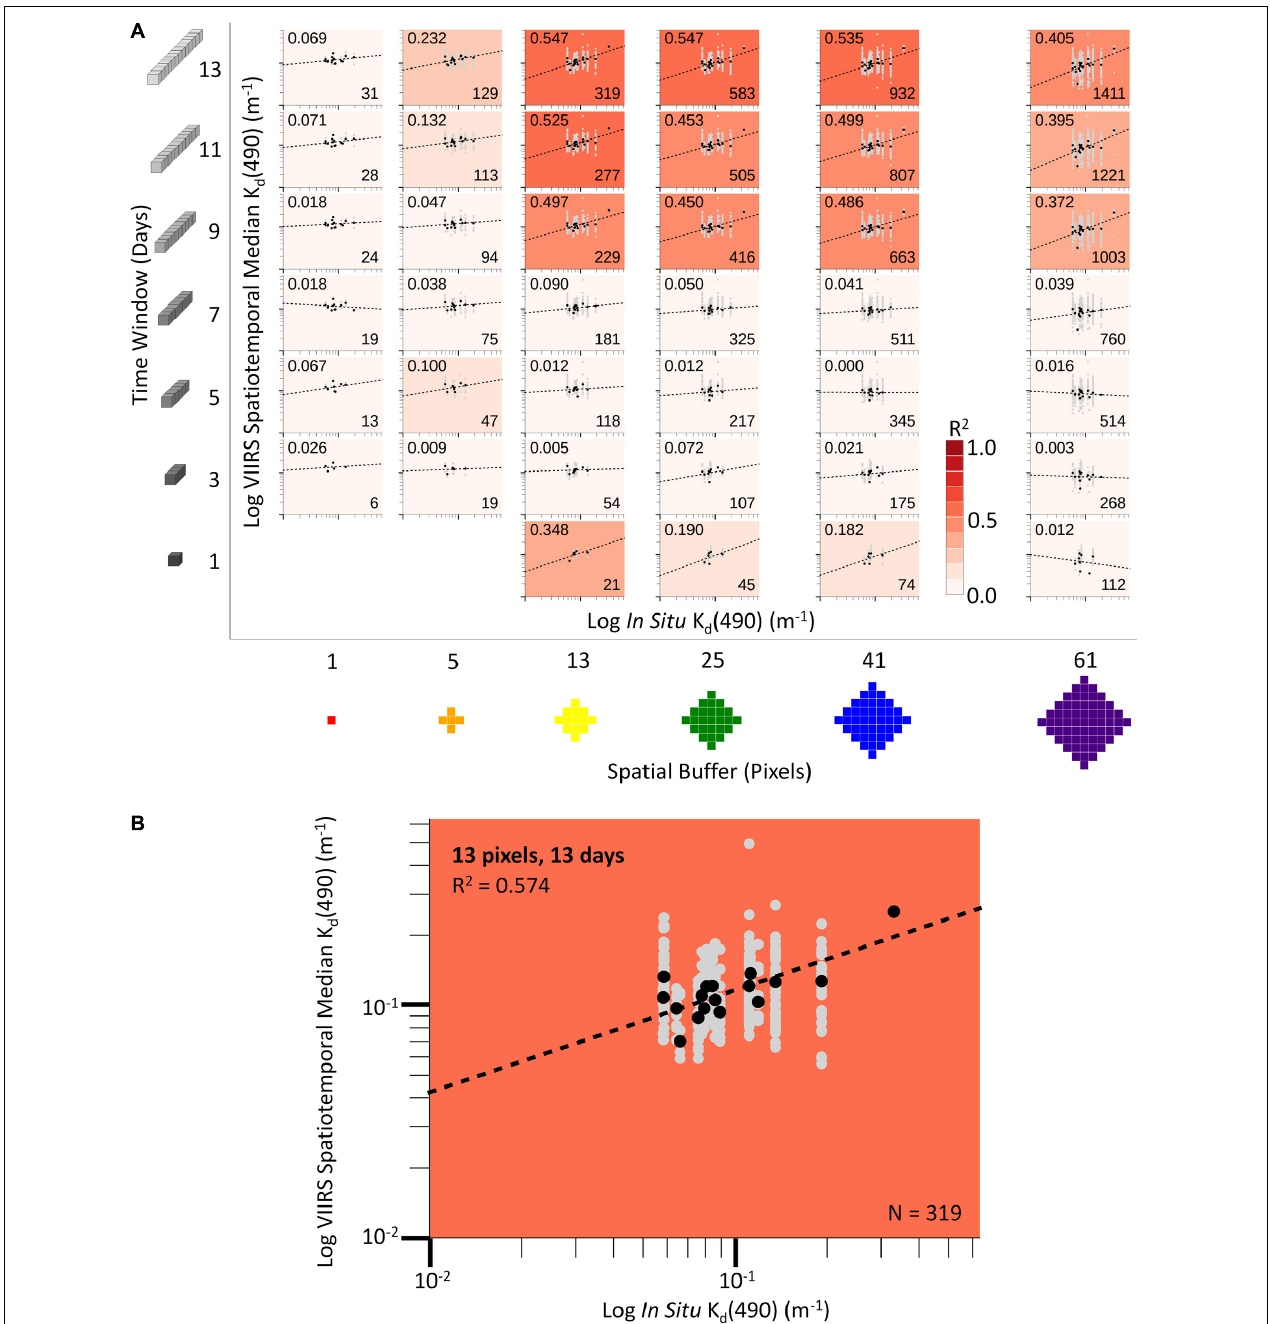
FIGURE 7 | (A) Correlation matrix of in situ and VIIRS measures of log-transformed K d (490) over a 4-years in situ measurement period at one southwest Puerto Rico location ( Figure 5 ) for a range of spatial buffers and time windows applied to the satellite data. The outer horizontal axis indicates the spatial buffer and the outer vertical axis represents the time window, with icons on each representing the space (or time) domain. Together, the time window and spatial buffer make the spatiotemporal cube of satellite data from which satellite values are compiled (gray circles) and the median of those is calculated. Shading of each plot represents the R 2 value of individual regression lines between the median satellite observation and the in situ observations. Scatterplots with two or fewer matchups are excluded. For each scatterplot, the horizontal axis values are the in situ observations from the site in Figure 3 , which were taken between 2016 and 2019, and the vertical axis values are all satellite observations associated with that in situ measurement within the time window and space buffer indicated. The number in the upper left corner is the R 2 value for that plot; the number in the bottom right corner is the total number of satellite observations (gray circles) displayed in the plot. (B) Enlarged scatterplot for recommended spatiotemporal aggregation (13-pixels, 13-days). Axis tick values in (B) are the same as all scatterplots in (A) and major tick marks are bold for all scatterplots.